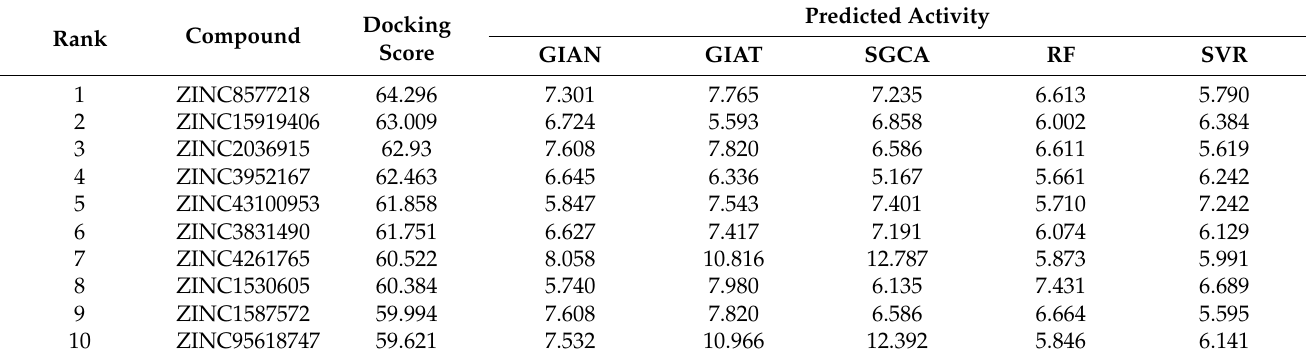
Table 3. Docking score and predicted activity value for the top 10 ZINC